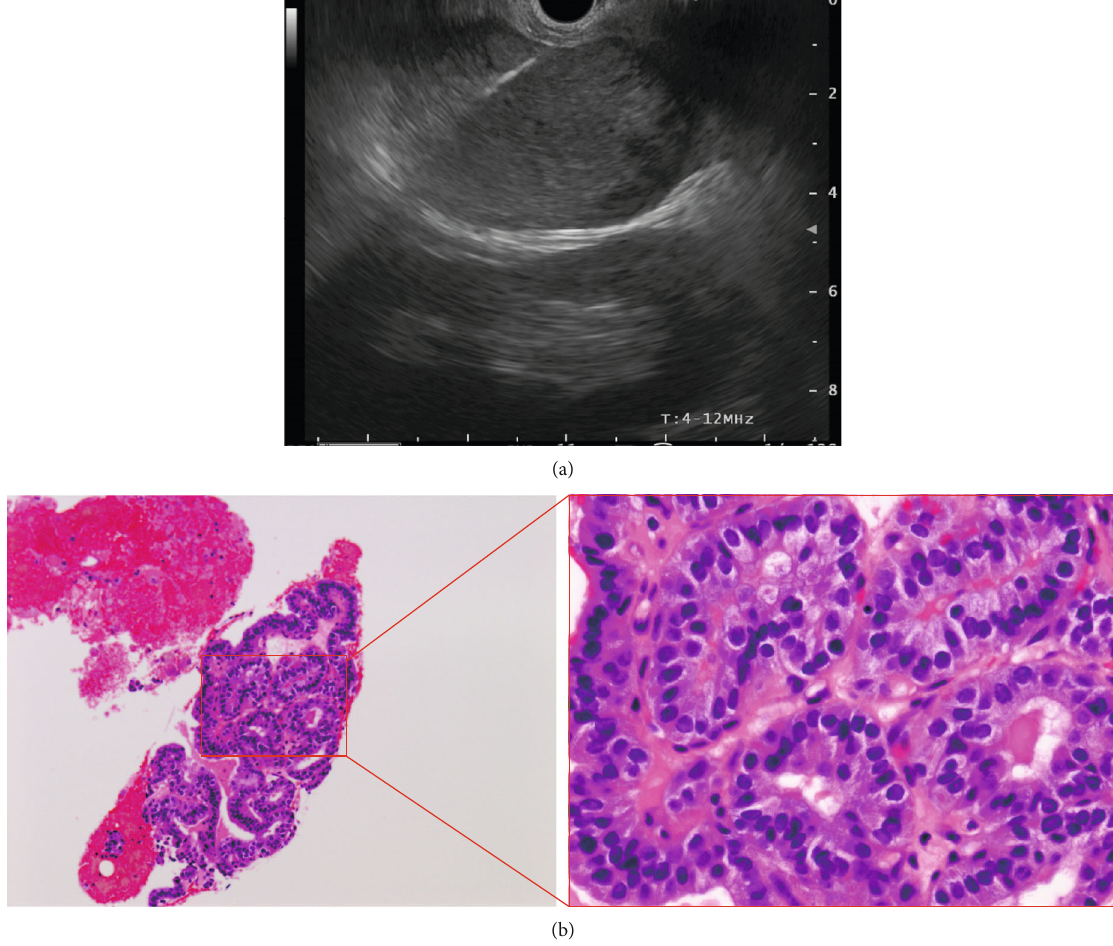
Figure 2: Endoscopic ultrasound-guided fi ne-needle aspiration (EUS-FNA) procedure and histopathological fi ndings. (a) EUS-FNA was performed on the left adrenal tumor from the posterior wall of the stomach. (b) Histopathological fi ndings showing a papillary structure similar to that of the resected thyroid cancer.